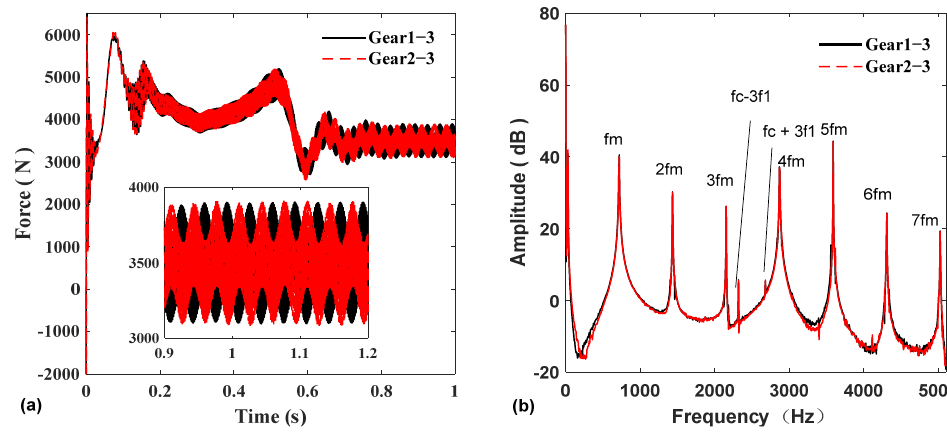
Figure 10. Gear 1–3, Gear 2–3 mesh force: ( a ) time domain; ( b ) frequency domain.